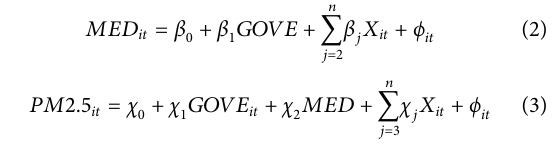
FIGURE 2 Roadmap of the impact of government environmental concerns on haze